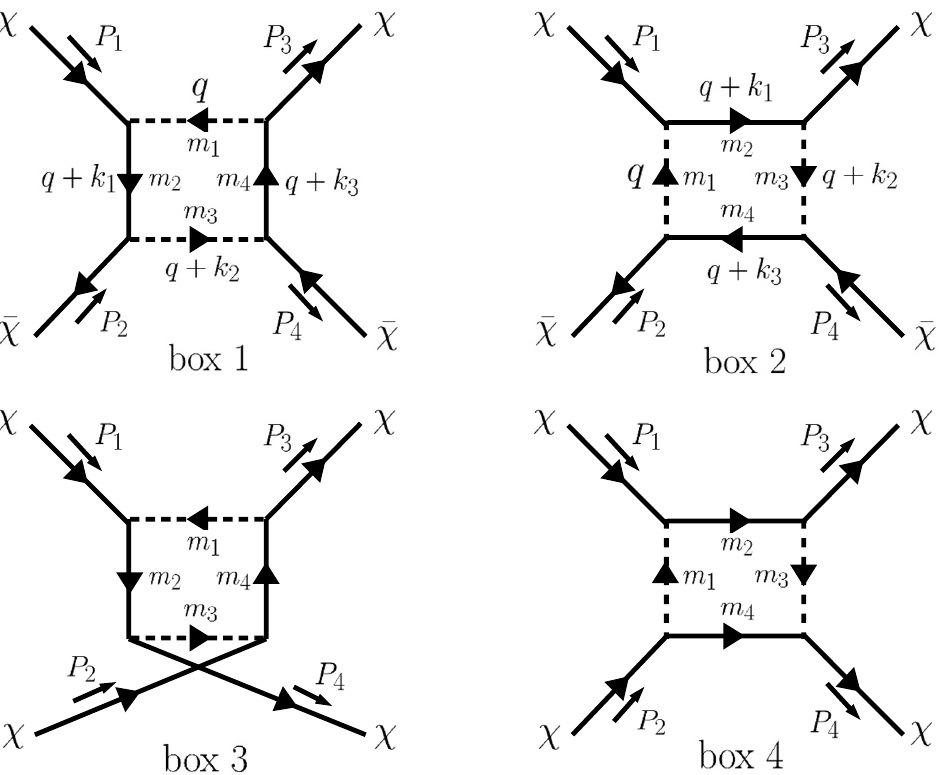
Figure 6 . Box-1 and box-2 are for (cid:22) (cid:31)(cid:31) ! (cid:22) (cid:31)(cid:31) , while box-3 and box-4 are for (cid:31)(cid:31) ! (cid:31)(cid:31) , where m 1 = m 3 = m (cid:30) , m 2 = m 4 = m ~ (cid:31) . In box-1, k 1 = p 1 , k 2 = p 1 + p 2 , k 3 = p 3 , while in box-2, k 1 = p 1 , k 2 = p 1 (cid:0) p 3 , k 3 = (cid:0) p 2 . The DM self-scattering cross section due to the g (cid:22) (cid:31)(cid:31)(cid:30) term has been calculated in (cid:31) ref. [19]. The velocity-dependent cross section, which is inversely related to the fourth power of the velocity, was proposed to solve the core-cusp problem. During DM capture by a NS the typical DM velocity reaches v ’ 0 : 63 c , which suppresses this cross section to (cid:27) e(cid:11) ’ 8 : 0 (cid:2) 10 (cid:0) 40 cm 2 . Thus, the DM self-scattering cross section from g (cid:22) (cid:31)(cid:31) becomes (cid:31) (cid:31)(cid:31) ! (cid:31)(cid:31) (cid:22)~ (cid:31)(cid:31)(cid:30) (via box diagrams), as we discuss below. comparable to that from (cid:21) (cid:30) (cid:22)~ (cid:31)(cid:31)(cid:30) term, are shown in (cid:12)gure 6. The DM self-scattering diagrams from the (cid:21) (cid:30)